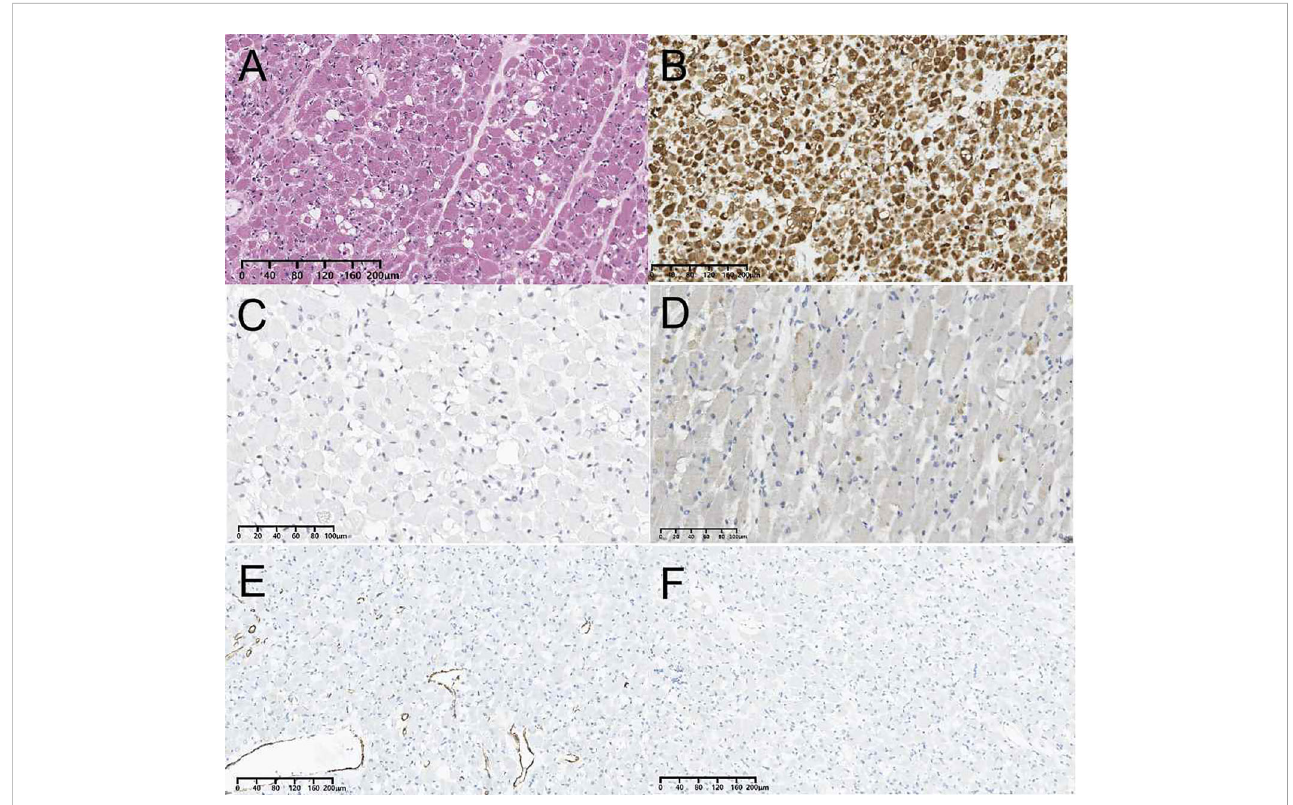
FIGURE 3 Pathological fi ndings of adult-type rhabdomyoma of the thyroid. (A) Histopathological section (hematoxylin and eosin staining). (B) Immunohistochemistry result showing the expression of desmin. (C) Immunohistochemistry result showing the expression of MyoD1. (D) Immunohistochemistry result showing the expression of myogenin. (E) Immunohistochemistry result showing the expression of smooth muscle actin. (F) Immunohistochemistry result showing the expression of S-100